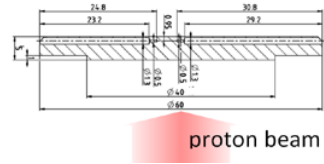
Fig. 4. The aluminum dummy-target for measurement of temperature distribution along beam spot using a set of thermocouples.